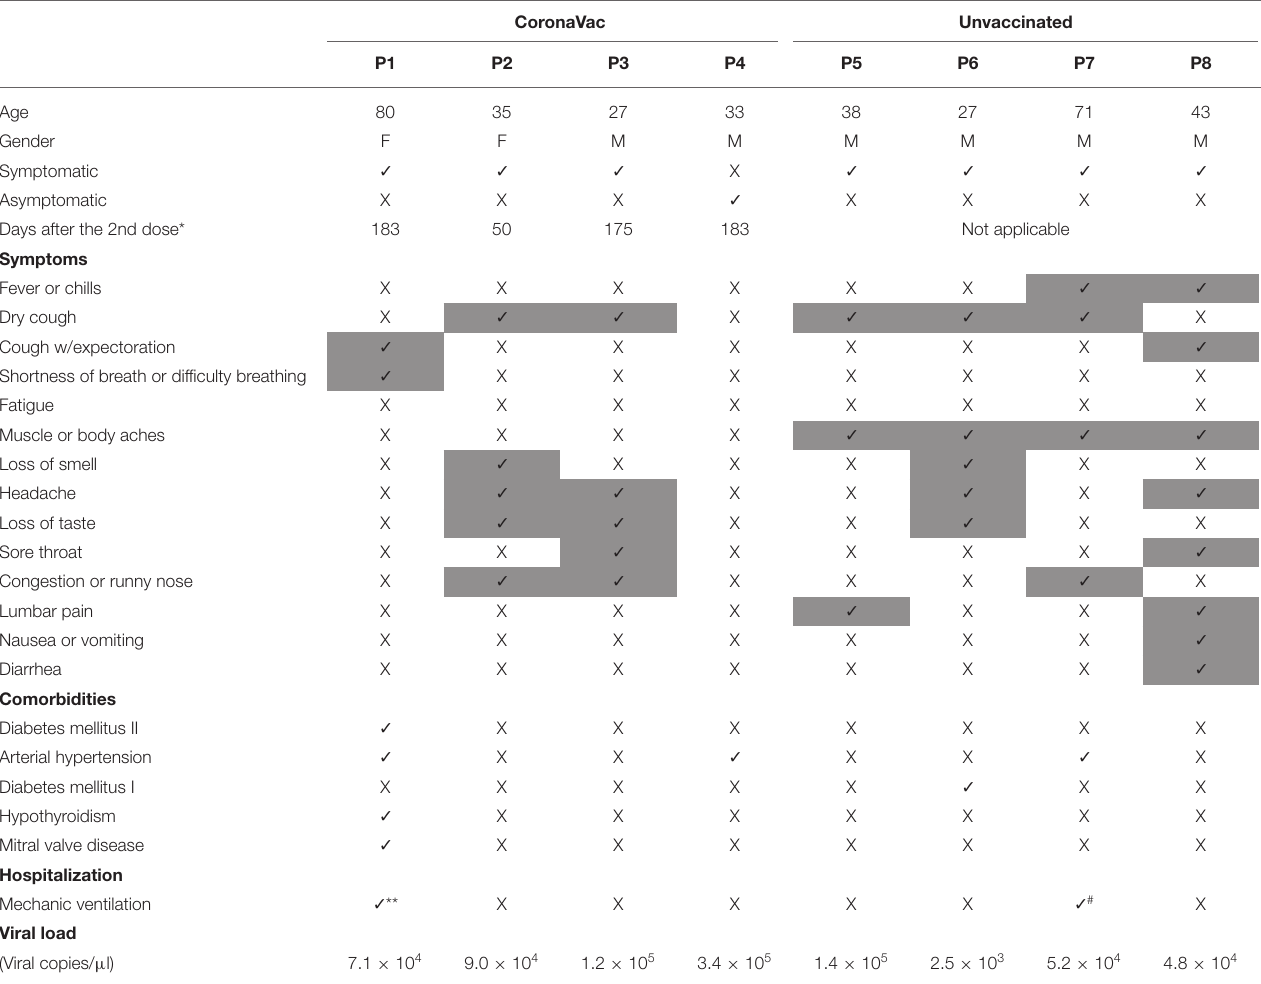
TABLE 2 | Specific symptomatology and clinical records reported by B.1.621 (Mu) variant infection in full vaccinated with CoronaVac and unvaccinated patients.